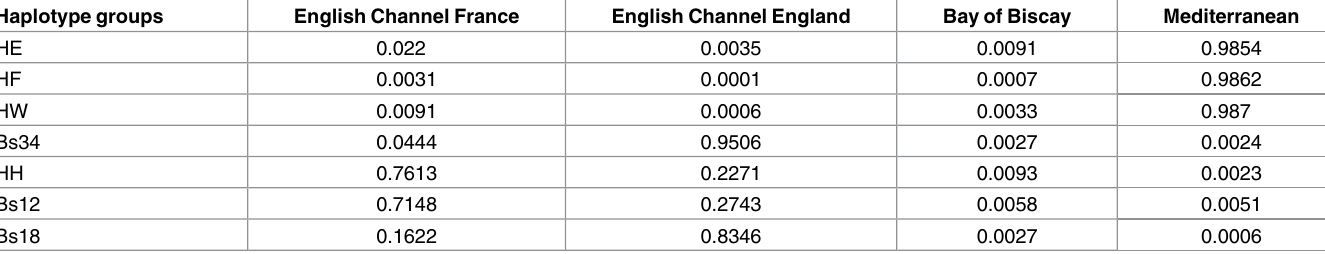
Table 7. Location posterior probabilities for Clade E haplotype